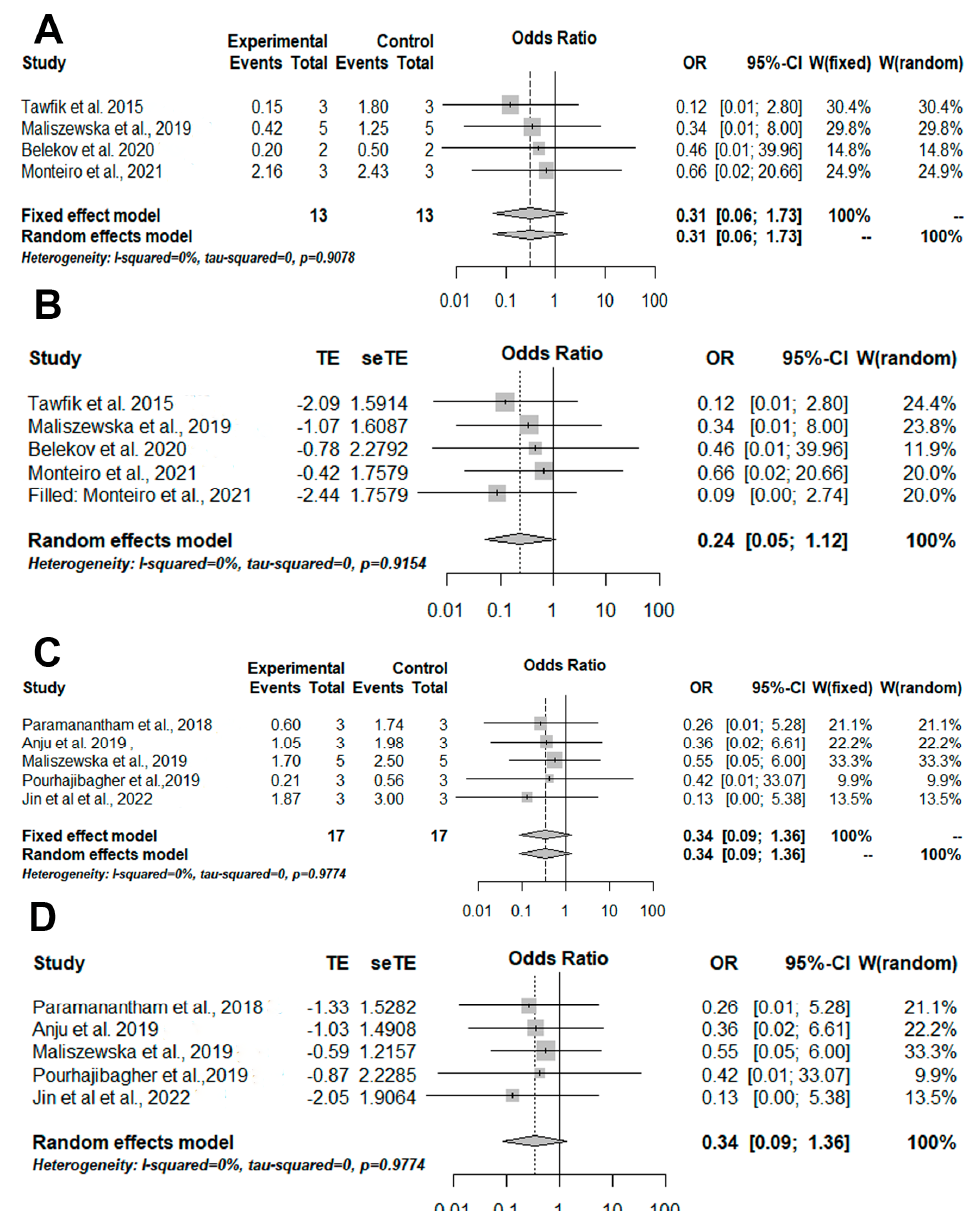
Figure 4. Illustration of meta-analysis and quantitative approaches. The experimental group was formed by aPDT mediated by photosensitizers conjugated inorganic nanoparticles and the control group was formed by aPDT only. ( A ) The results of meta-analysis illustrated in a forest plot for the viability of microbial cells cultured in suspension and treated with MB-mediated aPDT with or without photosensitizers conjugated with inorganic nanoparticles. ( B ) Trim-and-fill results for the viability of microbial cells cultured in suspension and treated with MB-mediated aPDT with or without photosensitizers conjugated with inorganic nanoparticles show the presence of publication and meta-analysis biases. ( C ) The results of meta-analysis illustrated in a forest plot for viability microbial cells cultured in biofilm. ( D ) Trim-and-fill results for viability microbial cells cultured in biofilm show the absence of publication bias. OR = odds ratio; CI = confidence interval; W: weight. TE = estimated mean; seTE = estimated standard deviation